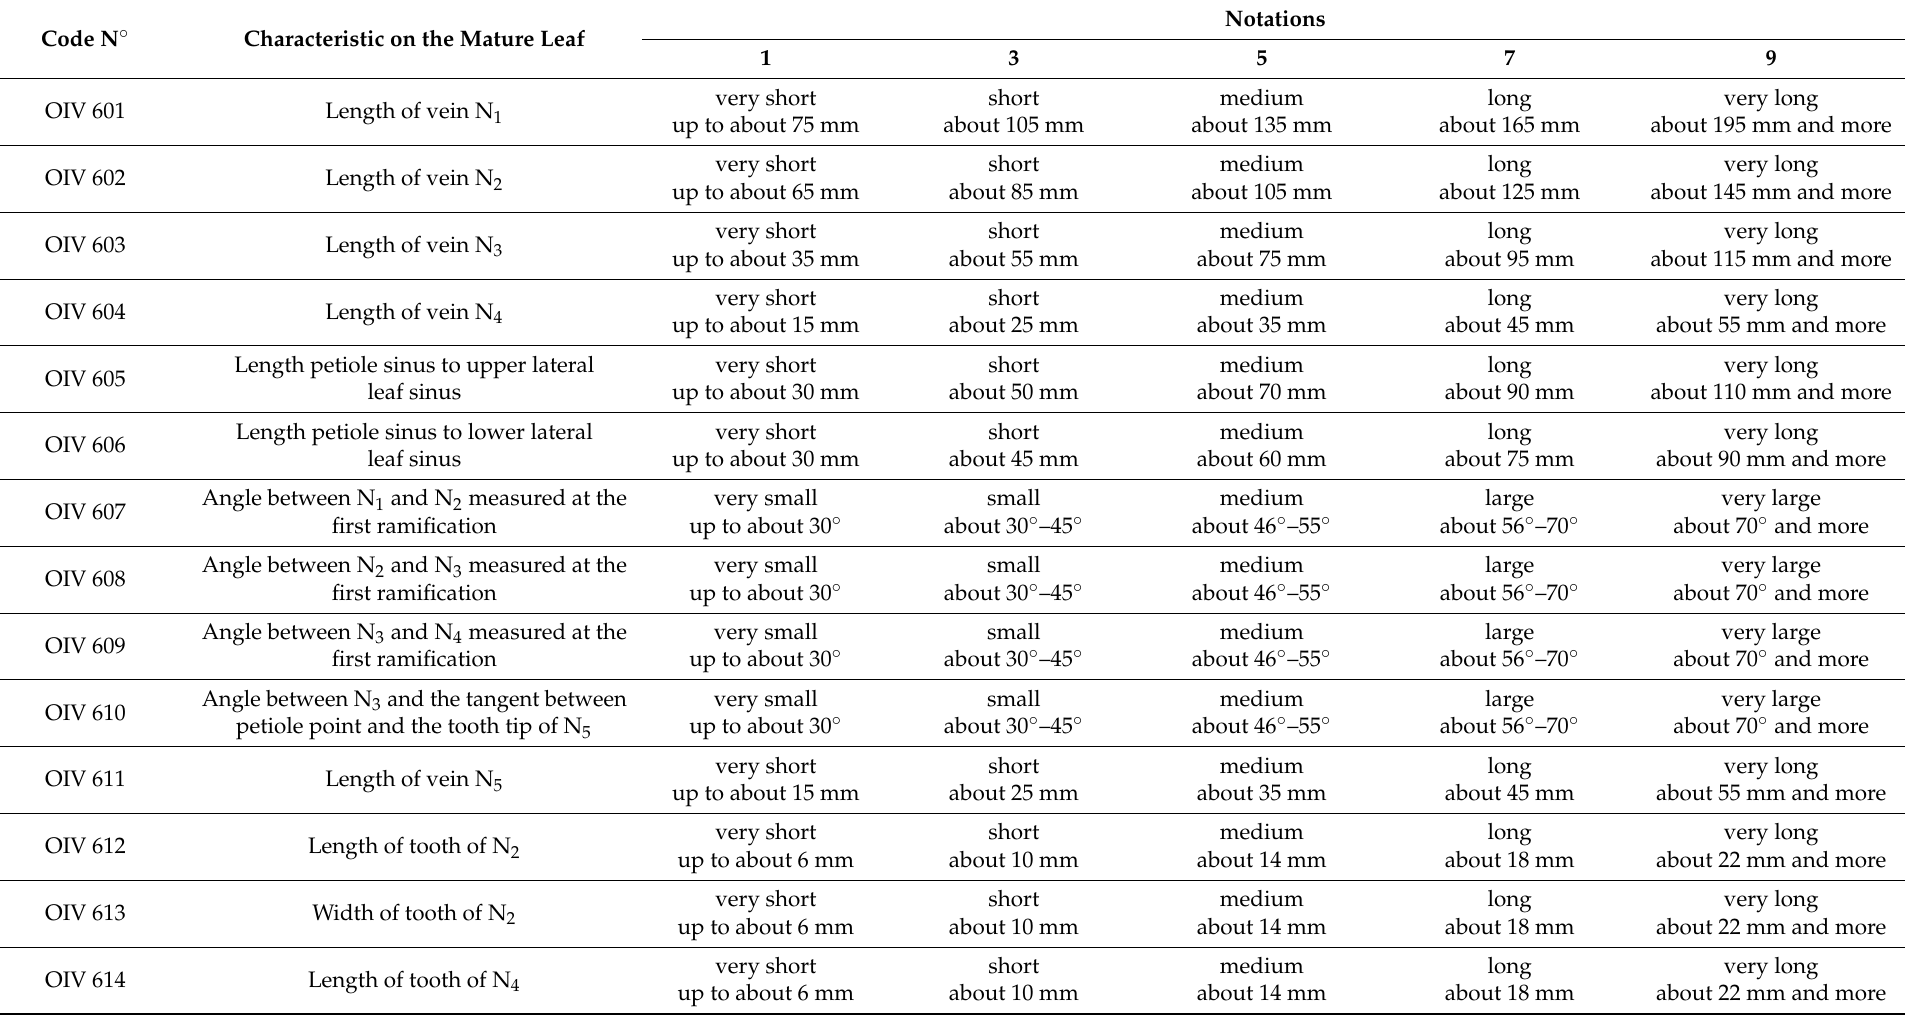
Table 1. Ampelometric characteristics in the OIV [7] descriptor